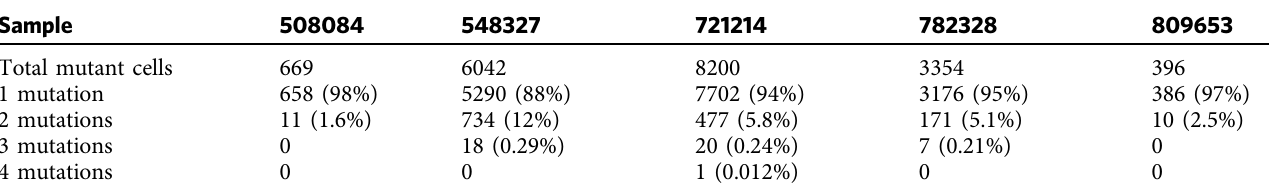
Original Table 2. Frequency of cells containing multiple mutations in each case.